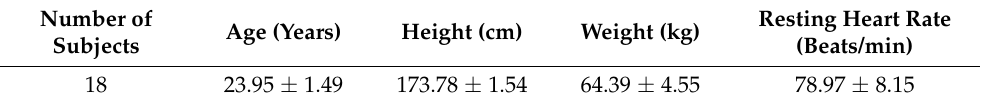
Table 1. Basic information of the subjects (M ±